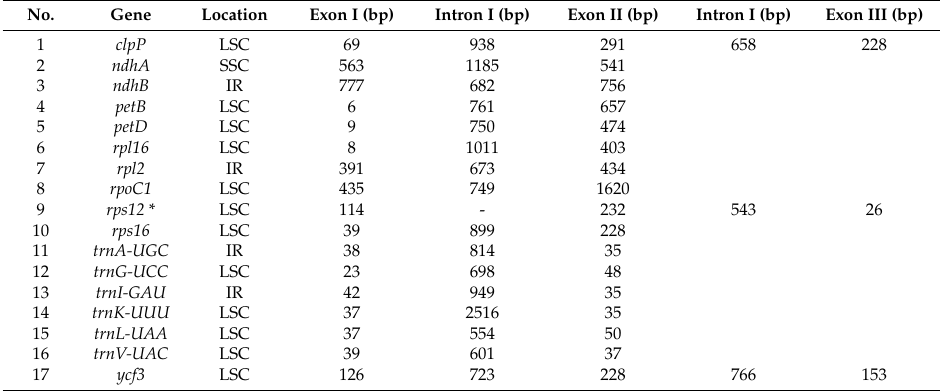
Table 3. The length of exons and introns in genes with introns in the Sanguisorba officinalis chloroplast